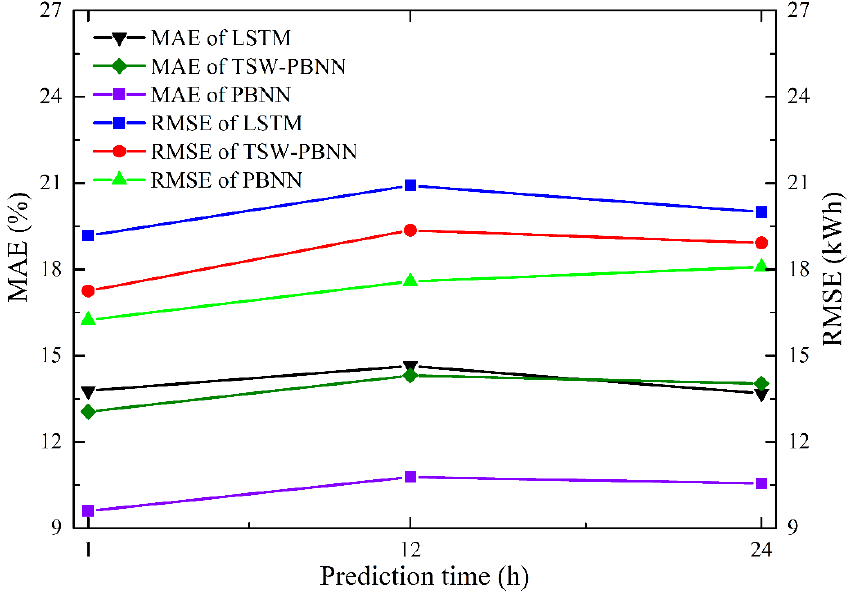
Figure 10. Error comparison of LSTM, TSW-PBNN, and PBNN predictions at different times.